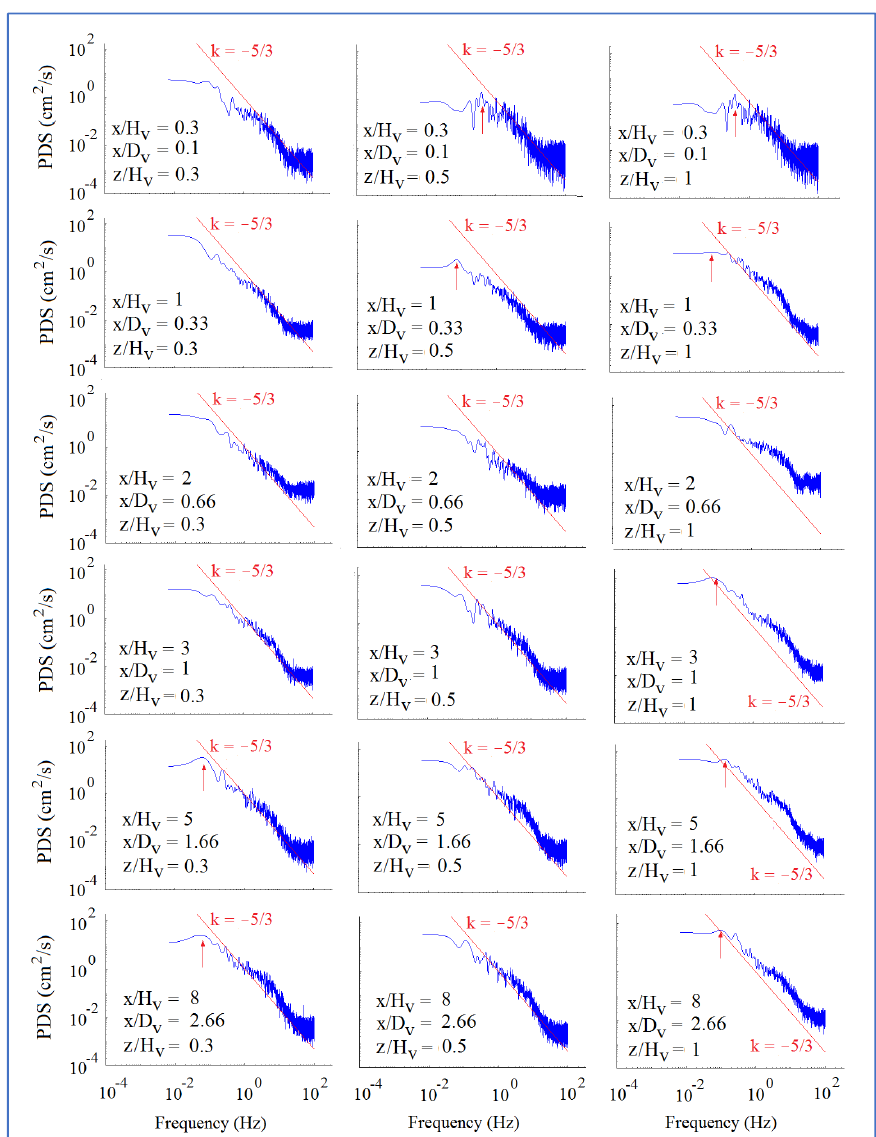
Figure 7. Power spectra behind vegetation patch for case 4; the arrow indicates the peak frequency associated with vortex shedding behind the patch, which varied from 0.07 to 0.11 Hz for main vortexes and is around 0.4 Hz for stem-scale vortexes.